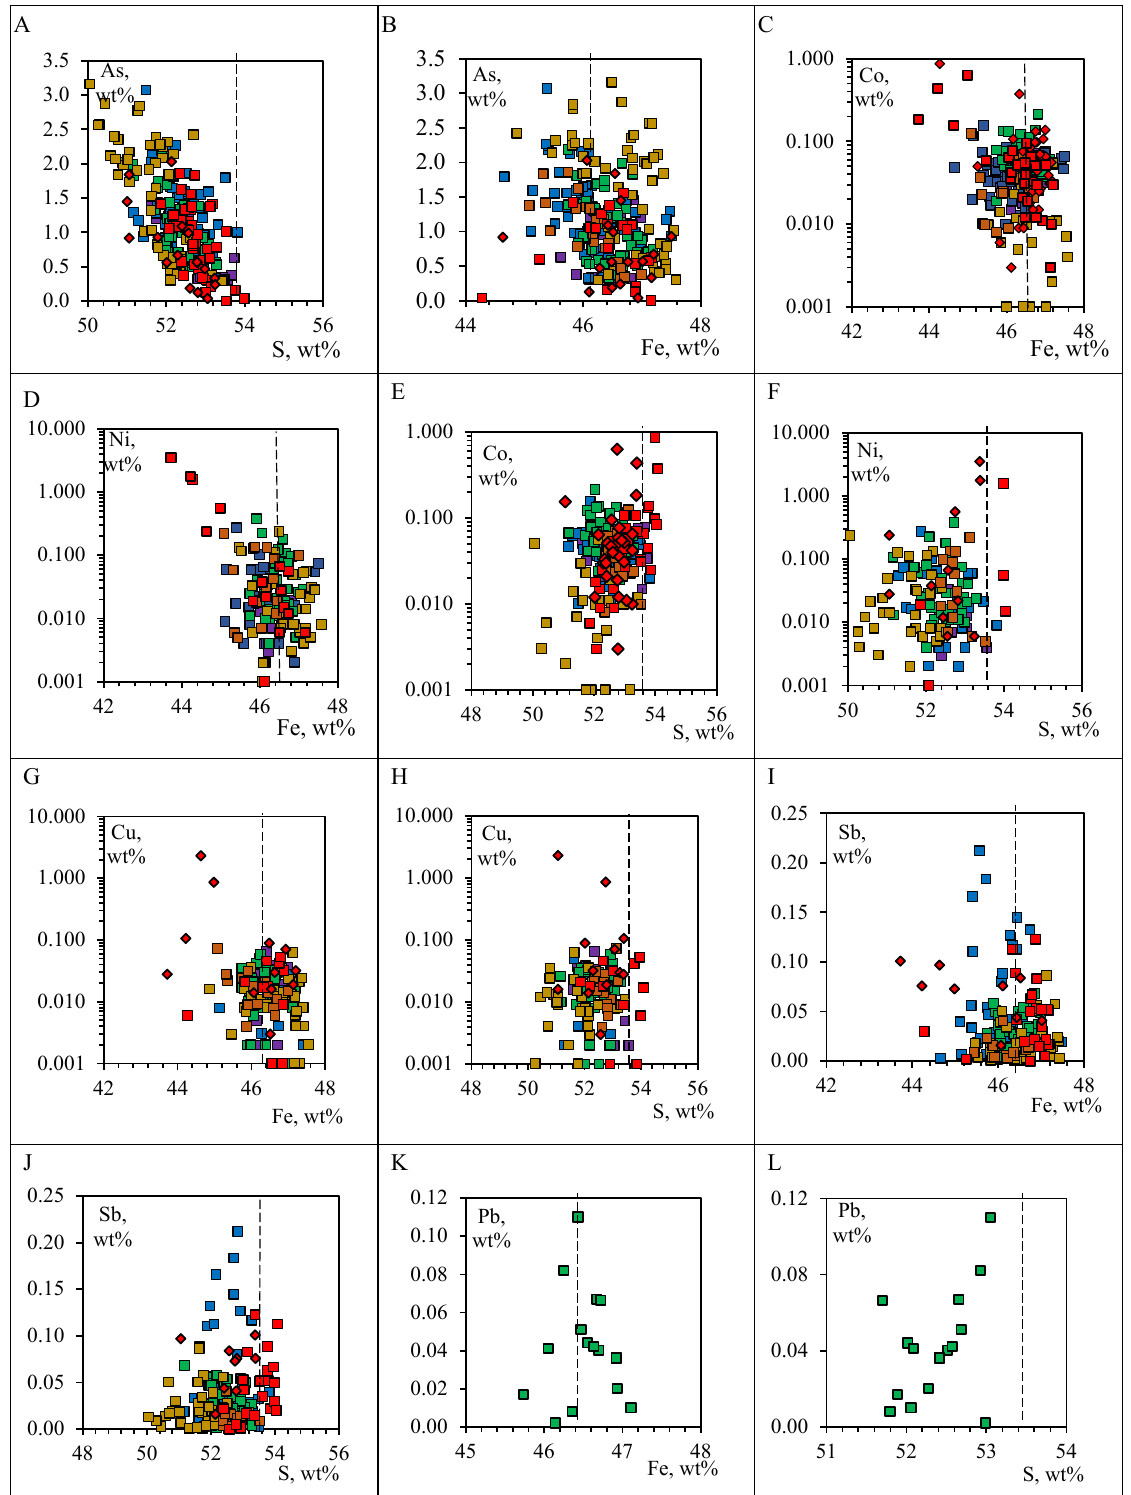
Figure 17. Diagrams of the ratios of concentrations of Fe, S, and trace elements in Py3 in the studied OGDs, central YKMB. ( A ) S vs. As; ( B ) Fe vs. As; ( C ) Fe vs. Co; ( D ) Fe vs. Ni; ( E ) S vs. Co; ( F ) Fe vs. Ni; ( G ) Fe vs. Cu; ( H ) S vs. Cu; ( I ) Fe vs. Co; ( J ) S vs. Cu; ( K ) Fe vs. Pb; ( L ) S vs. Pb. Negative correlation indicates isomorphic substitution. The lines Fe = 46.547 wt% and S = 53.453 wt% correspond to the stoichiometric composition of pyrite. See symbols in Figure 16.